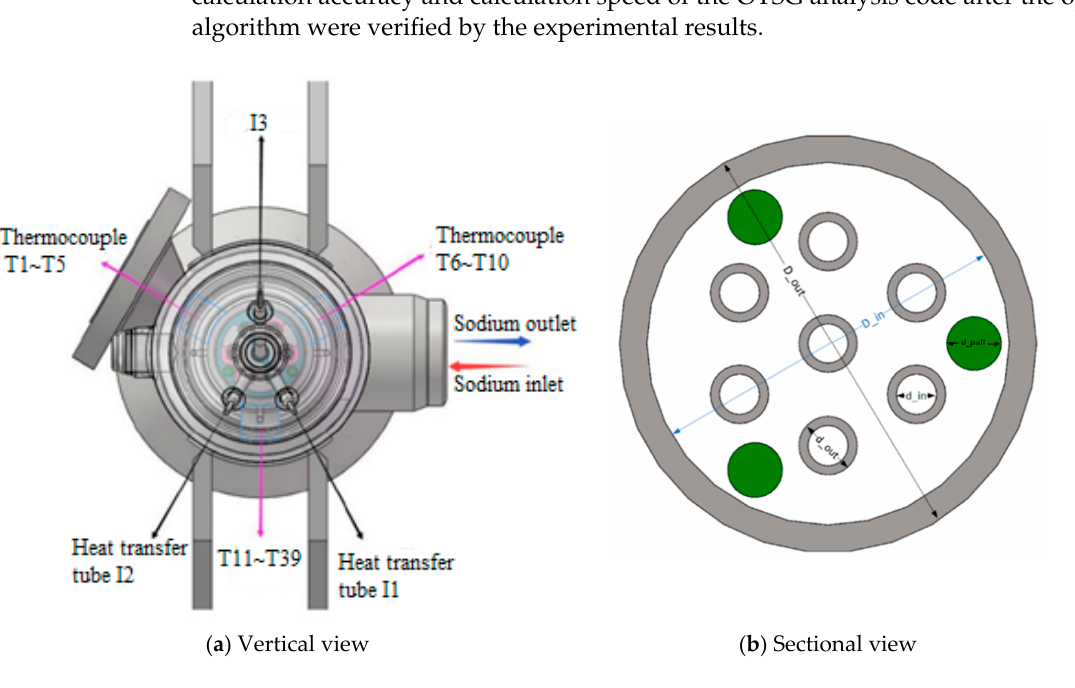
Figure 7. Vertical and sectional view of the seven-tube prototype.